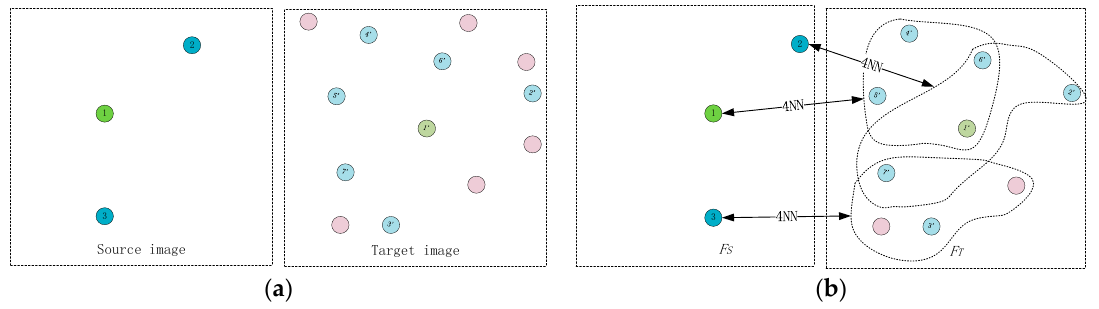
Figure 5. An illustration of outlier filtering, the pink dots are outliers: ( a ) original detected feature points are shown in ( a ); while filtered feature sets are shown in ( b ).